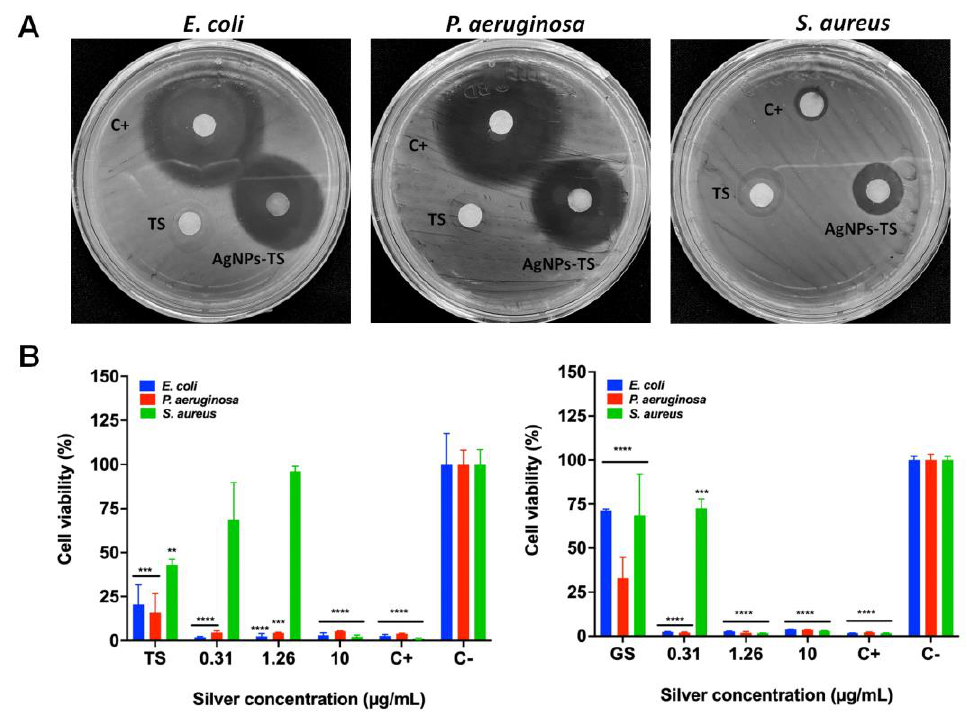
Figure 7. Representative images of bacterial inhibition strains with biosynthesized AgNPs ( A ) and cell viability of bacteria ( B ) after exposed to AgNPs for 24 h. Results are expressed as the mean ± SD (n = 3) ** p < 0.01; *** p < 0.001; **** p > 0.0001 using two-way ANOVA with a Dunnett’s multiple comparisons tests.